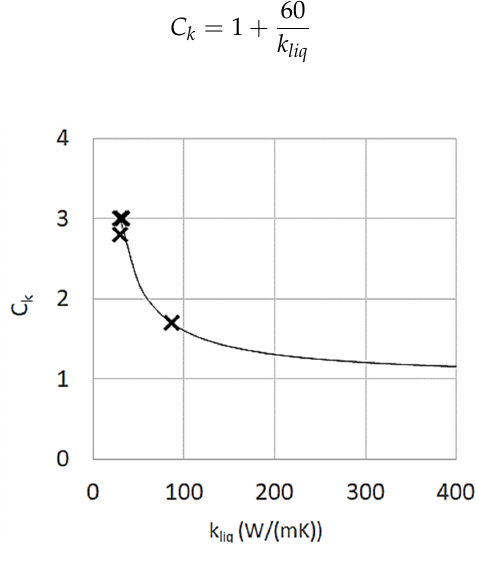
Figure 4. Fitted values of the multiplying parameter C k .